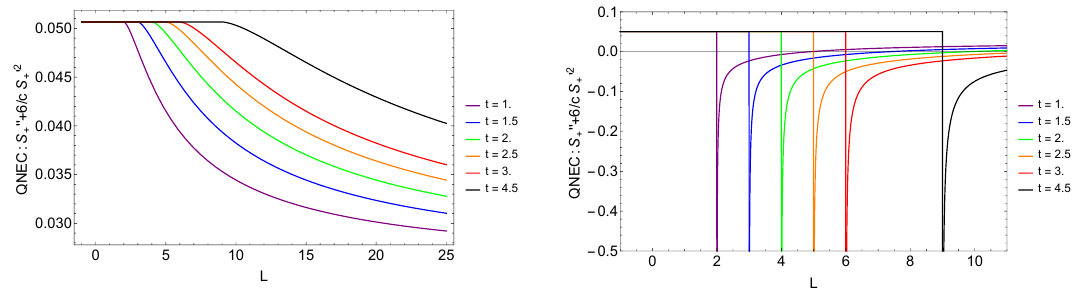
Figure 7: QNEC for perturbative Vaidya. Left: negative deformation. Right: positive